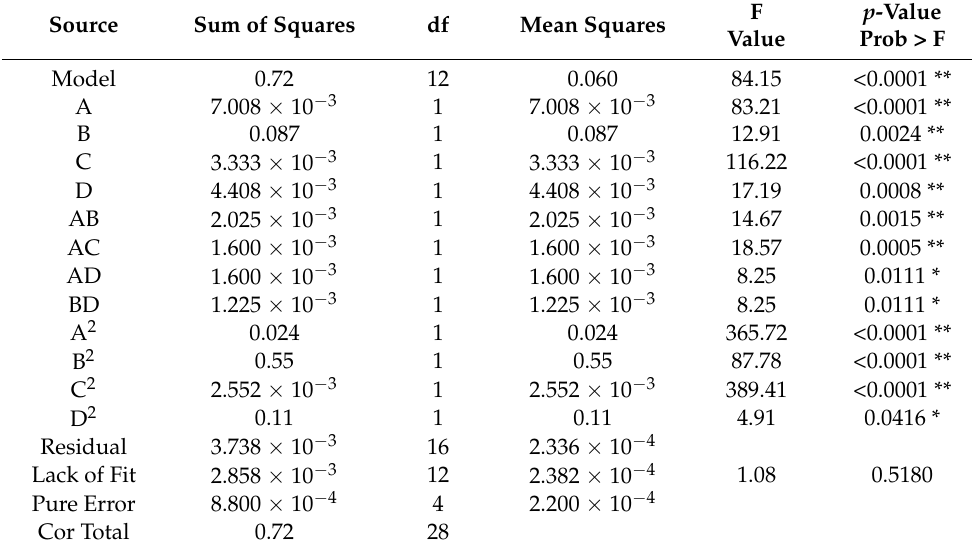
Table 6. Variance analysis of the ear impurity